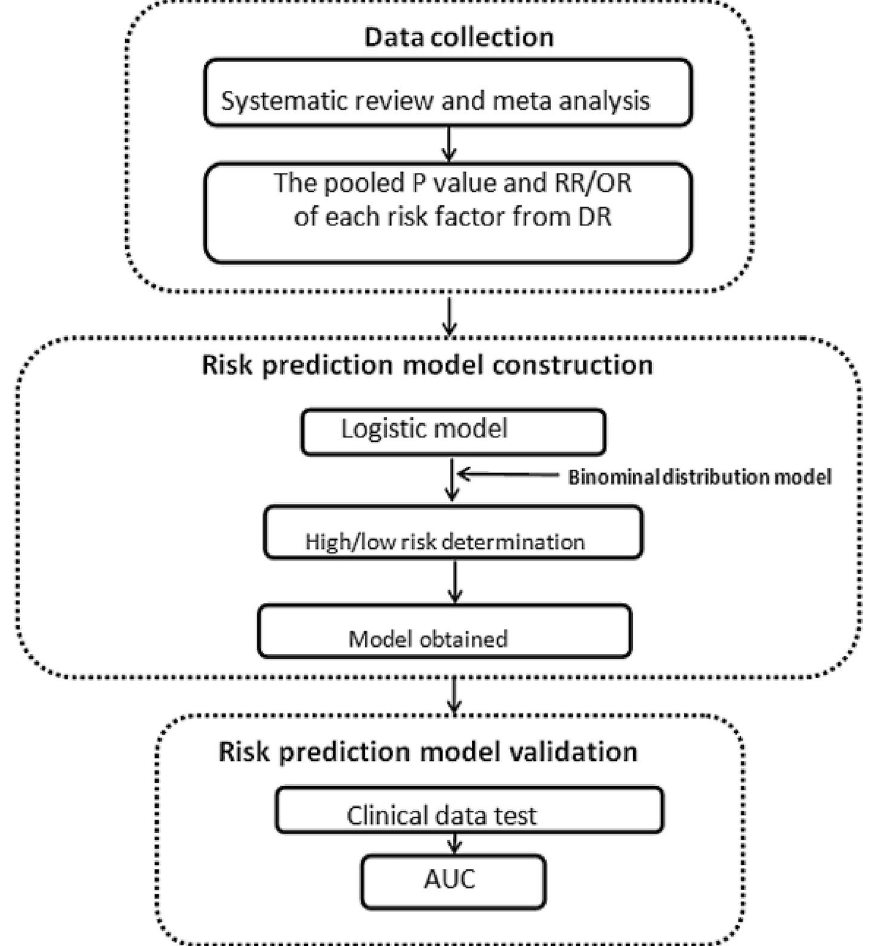
Figure 1. The workflow diagram of this